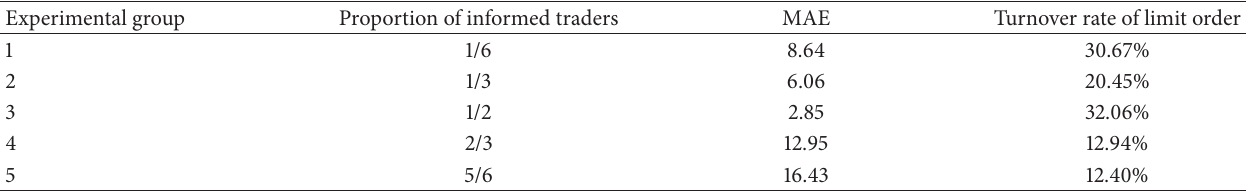
Table 3: Statistical results in each experimental